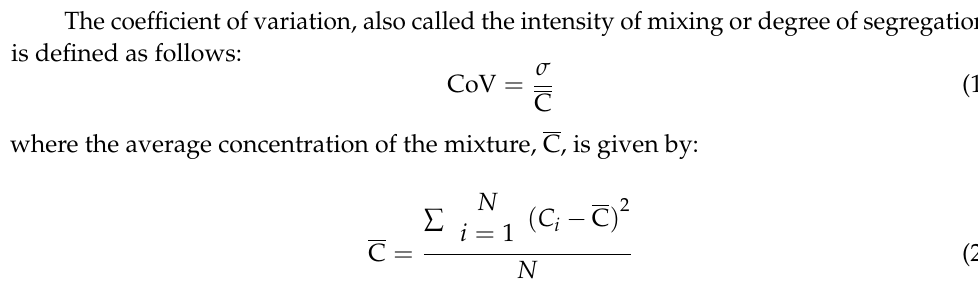
Figure 2. Schematic diagram of computational domain with meshes. Table 1. Dimensions of the Kenics static mixers.